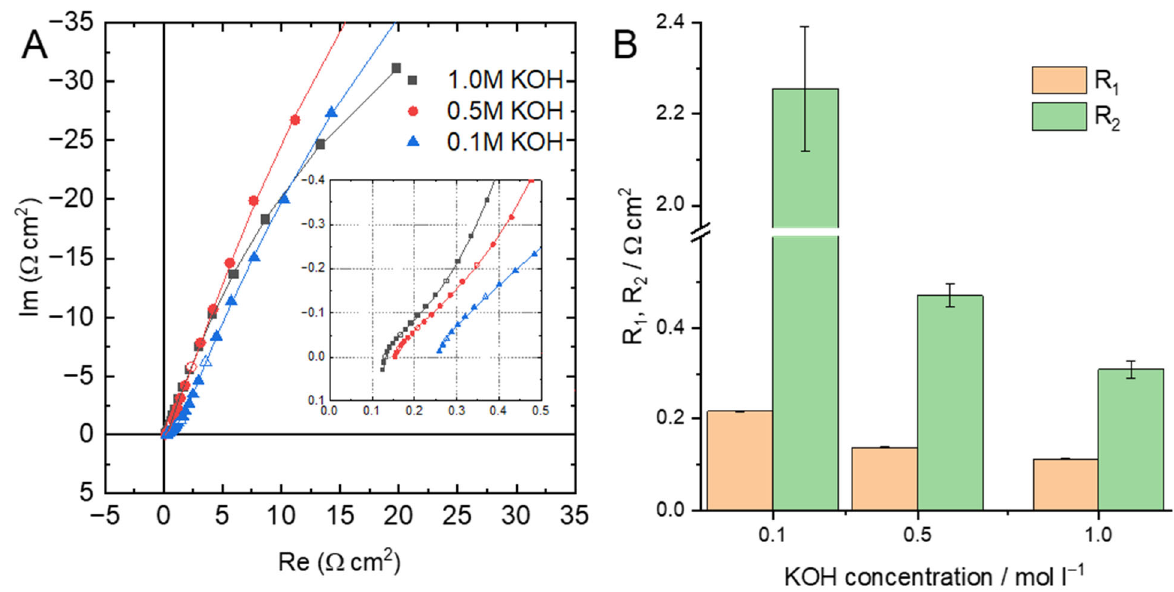
Figure 5. The effect of supporting electrolyte concentration on ohmic resistance and high-frequency resistance R 2 values: Nyquist plots ( A ) and the comparison of R 1 and R 2 values ( B ) measured at cell voltage 1.4 V and 50 °C. Reference EIS dots obtained at ca. 0.1, 1.0, 11, 116, 1200, and 8700 Hz are given as open symbols. The fitting is shown as lines.